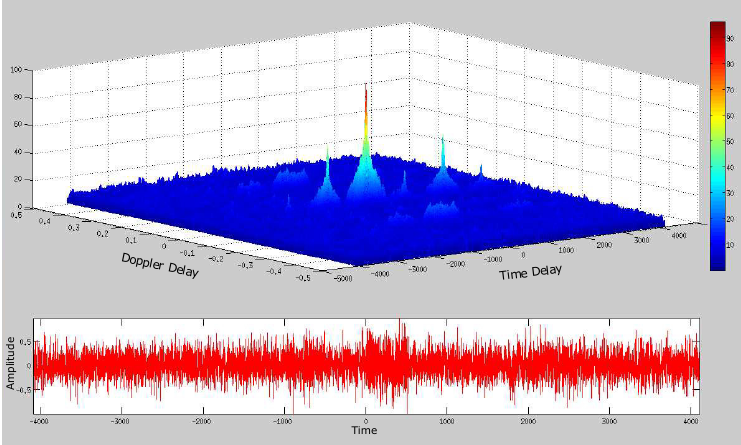
Figure 30. Multiple object tracking using MMPP “chirp pulses”, at Tracking Time 3, with − 5 dB